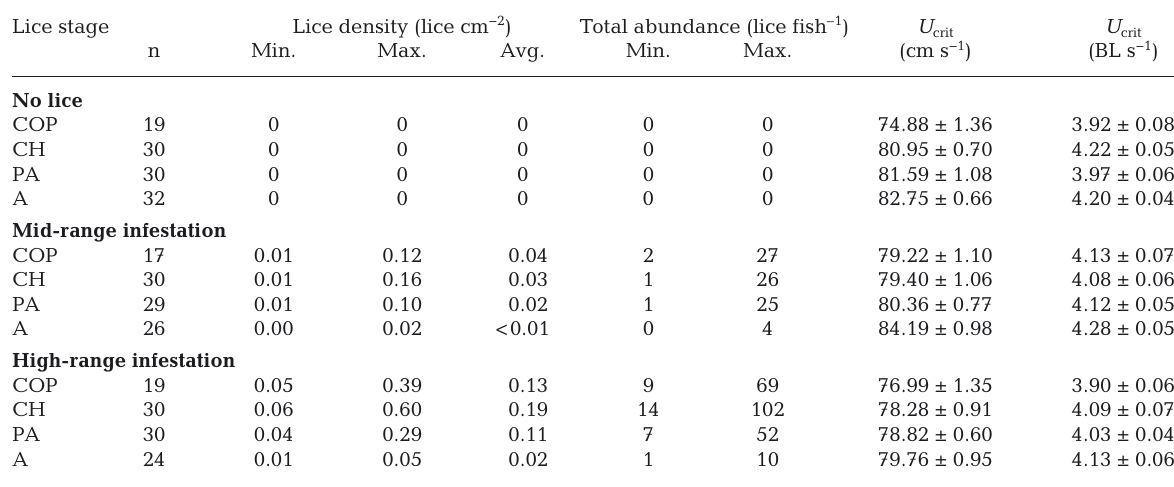
Table 1. Levels of parasite Lepeophtheirus salmonis load (lice density, corrected for body size of host Atlanic salmon Salmo salar) , total abundance on the fish, and critical swimming speed ( U crit , mean ± SE) for each infestation intensity and sea lice stage (COP: copepodid, CH: chalimus, PA: pre-adult, A: adult). Infestation intensities are 0 (no lice), 30 (mid-range) and 90 (high-range) copepodids per fish. BL: body